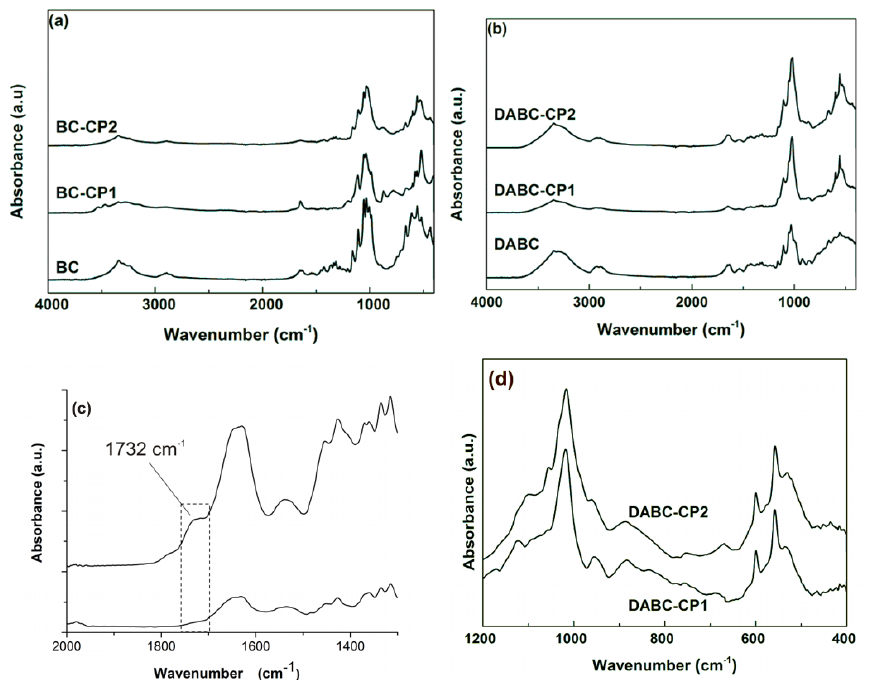
Figure 4. FTIR spectra of the studied samples: ( a ) BC, BC-CP1, and BC-CP2; ( b ) DABC, DABC-CP1, and DABC-CP2; ( c ) comparison between BC and DABC spectra in the range of 1400–2000 cm − 1 ; and ( d ) subtracted spectra of DABC-CP1 and DABC-CP2 (reported to DABC).